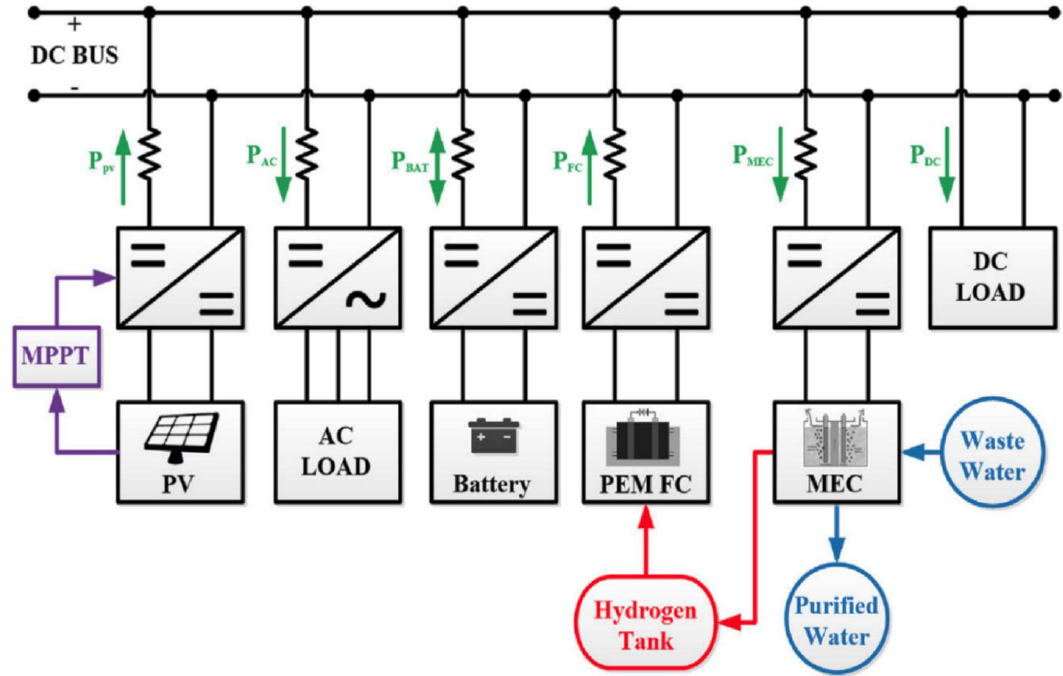
Figure 4. Schematic representation of an AC/DC PV-RHFC microgrid with wastewater treatment capability. Reprinted with permission from Ref. [44]. 2018, Elsevier.